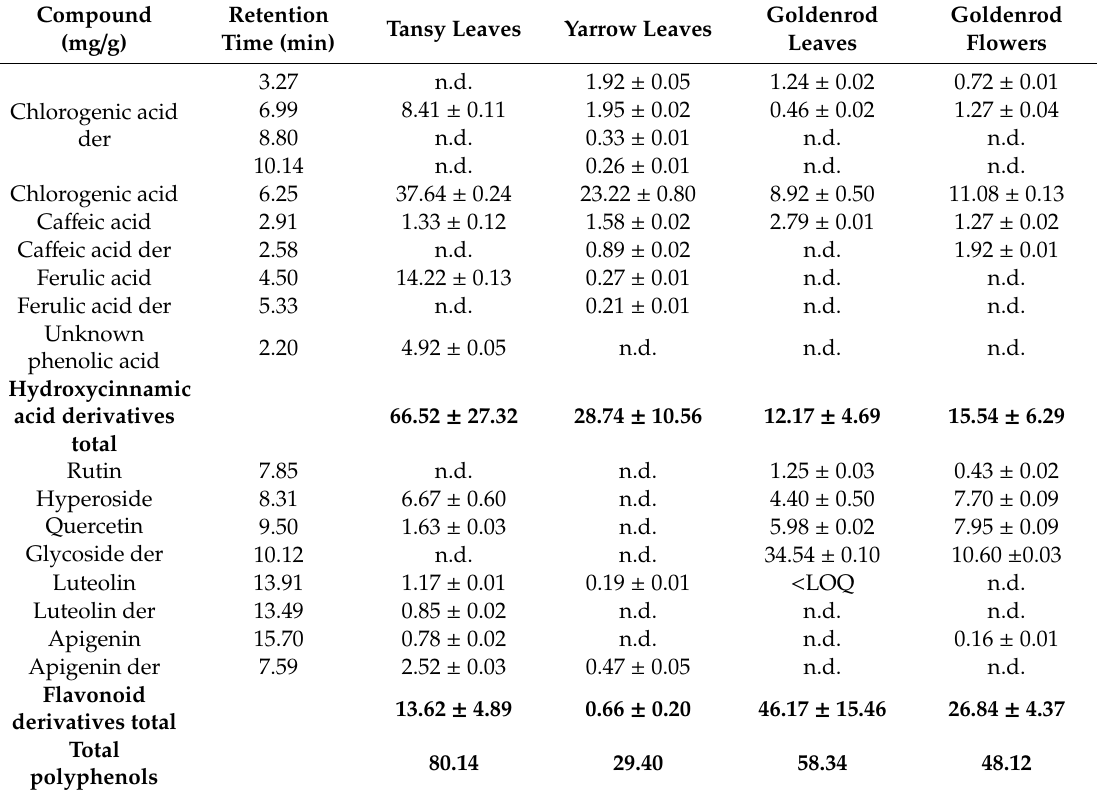
Table 3. Content of phenolic compounds (mg / g) in tested plant